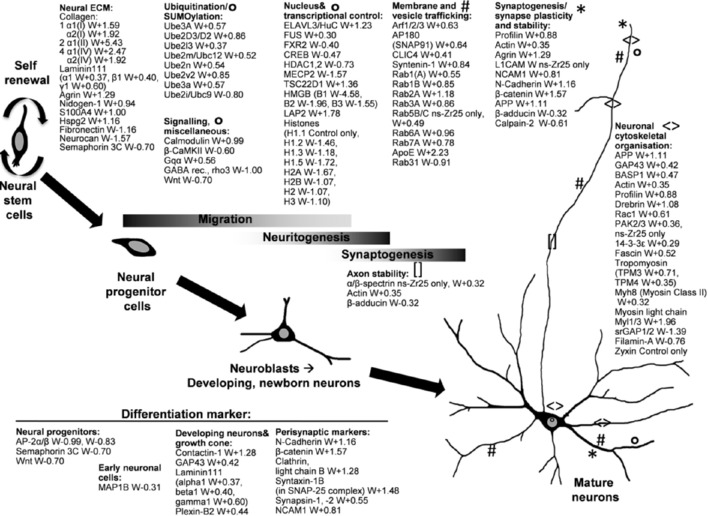
Selection of changes in the cellular program induced by the interaction with the nanostructured zirconia surface (ns-Zr25) compared to the Control. The graphical illustration accentuates various exemplary proteins which were altered in their expression levels in neurons grown on ns-Zr25 compared to the Control condition and are known to have prominent roles in processes important for neurogenic development and or integrin adhesome-, cytoskeleton- mechanotransduction-related processes. Further information on many of these proteins is provided in the main text. The numbers behind the protein names indicates the Welch difference (W). Complete lists of the differentially expressed proteins can be found in Tables S1, S2, with IAC proteins [according to Winograd-Katz et al. (2014)] marked in bold. Further IAC proteins [according to Geiger and Zaidel-Bar (2012)] are listed in Table S5.